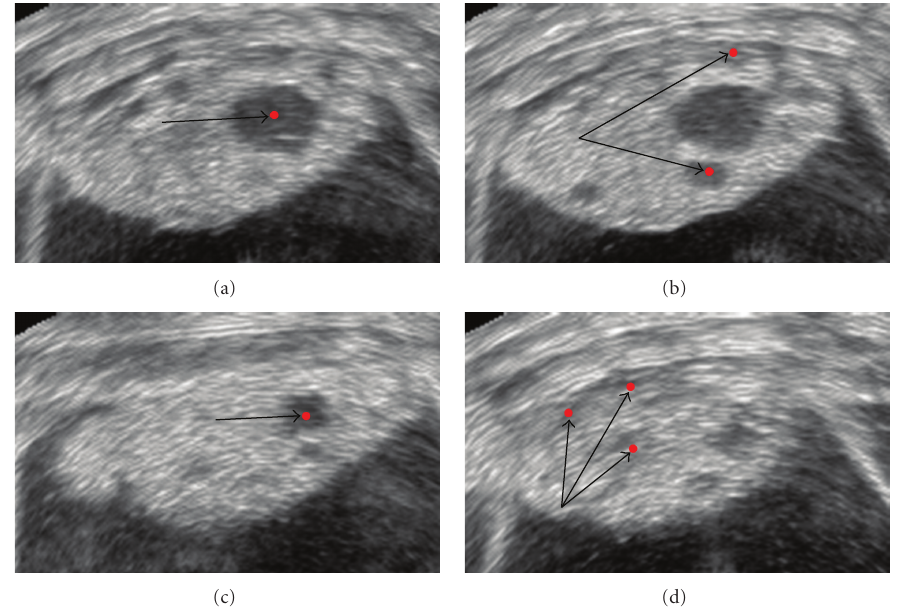
Figure 3: Follicle detection. 2D slices of the 3D ultrasound image smoothed data set corresponding to one of the patients. Lighter areas display the ovary; dark circular blobs are the follicles. Red dots indicate retrieved local minima in 3D at scale s = 9 voxels.